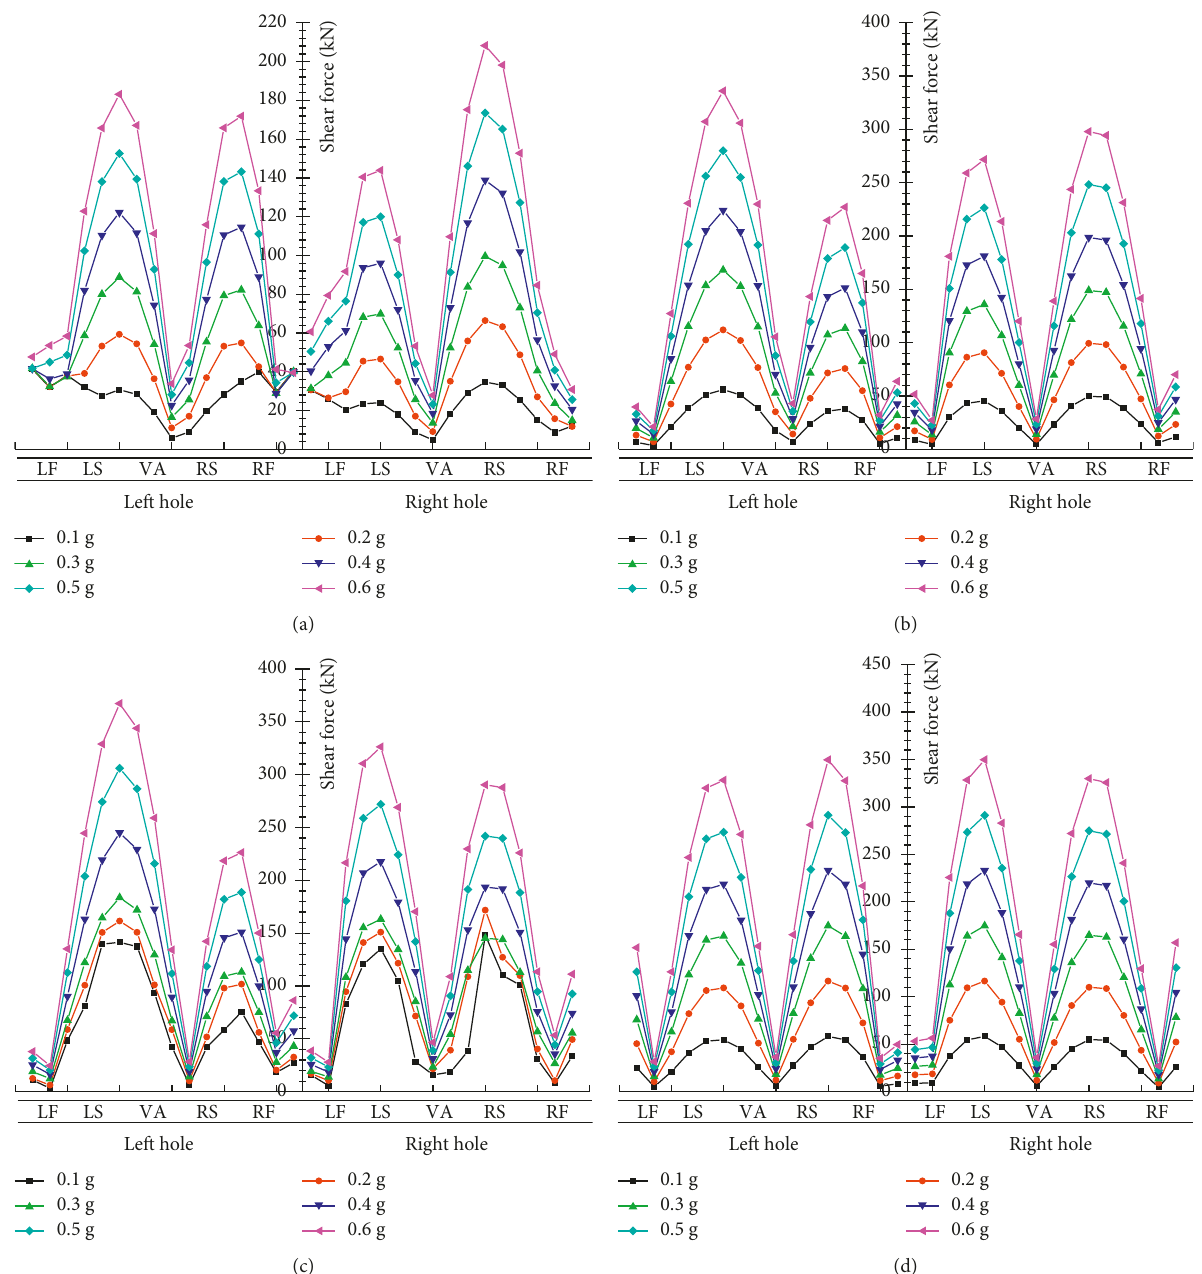
Figure 6: Shear force of tunnel crosssection of different existing slope angles. (a) 30 ° , (b) 45 ° , (c) 60 ° , and (d) 90 °